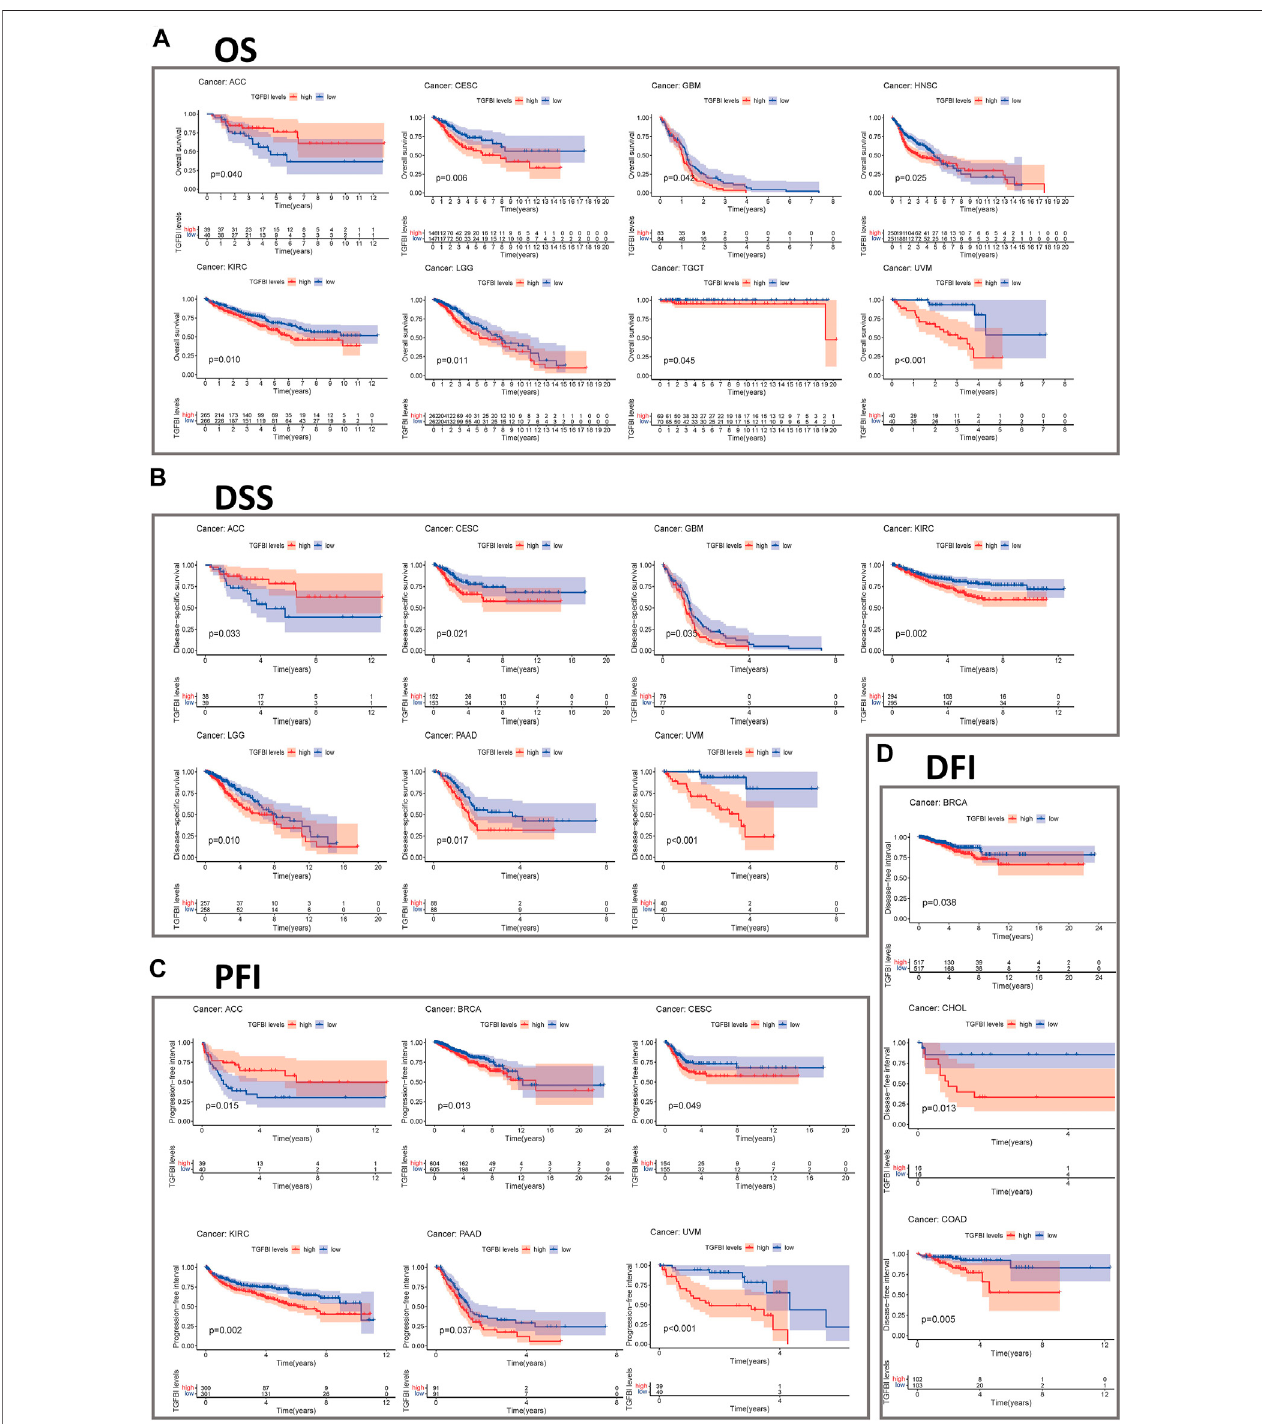
FIGURE 5 | Kaplan – Meier survival curves comparing pan-cancer high and low expression of TGFBI . (A) OS survival curves for TGFBI in different cancers; (B) DSS survival curves for TGFBI in different cancers; (C) PFI survival curves for TGFBI in different cancers; (D) DFI survival curves for TGFBI in different